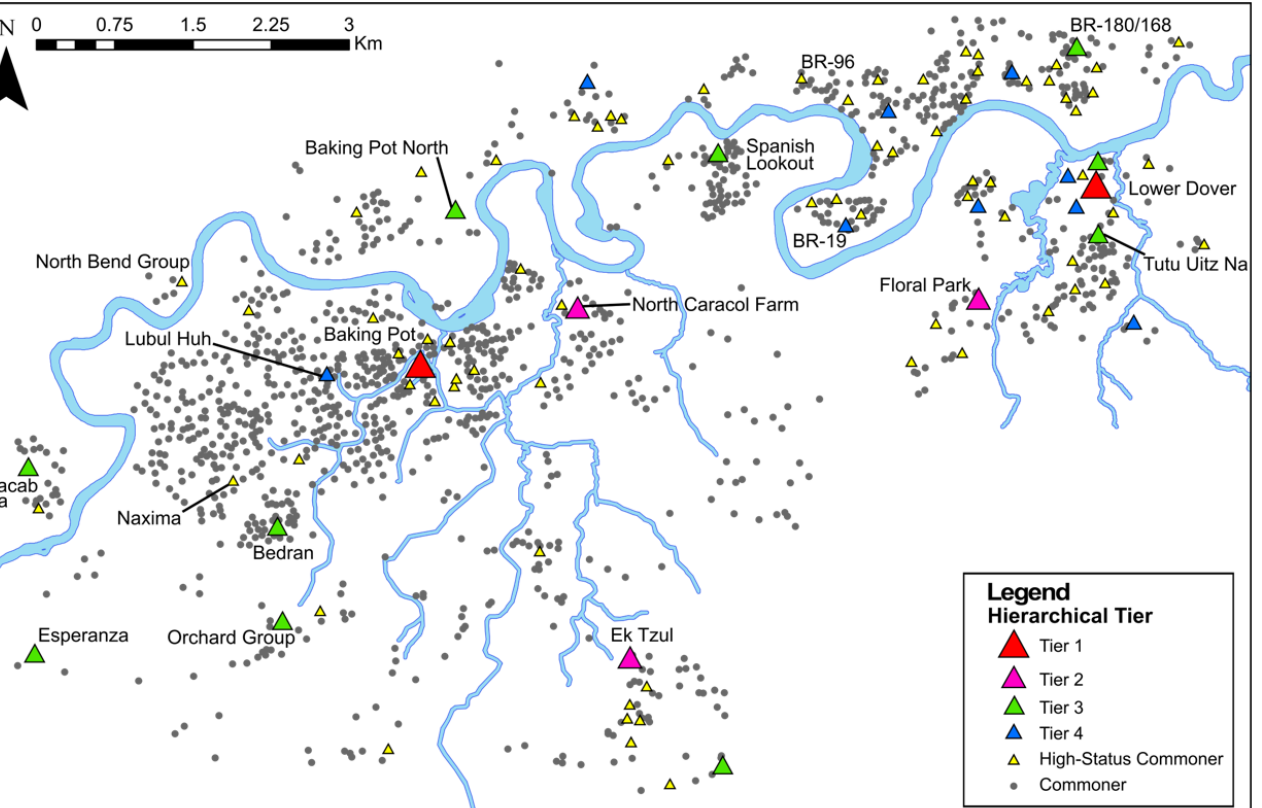
Figure 3. Map of Baking Pot and Lower Dover.